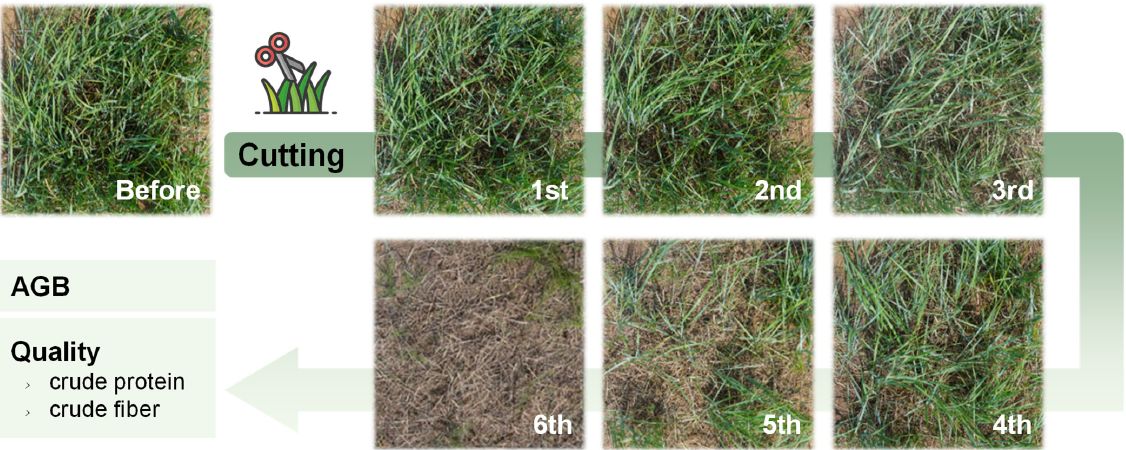
Figure 2. An example of the gradient grass-cutting experiment. The gradual grass-cutting here cre- ated seven coverage gradients. created seven coverage